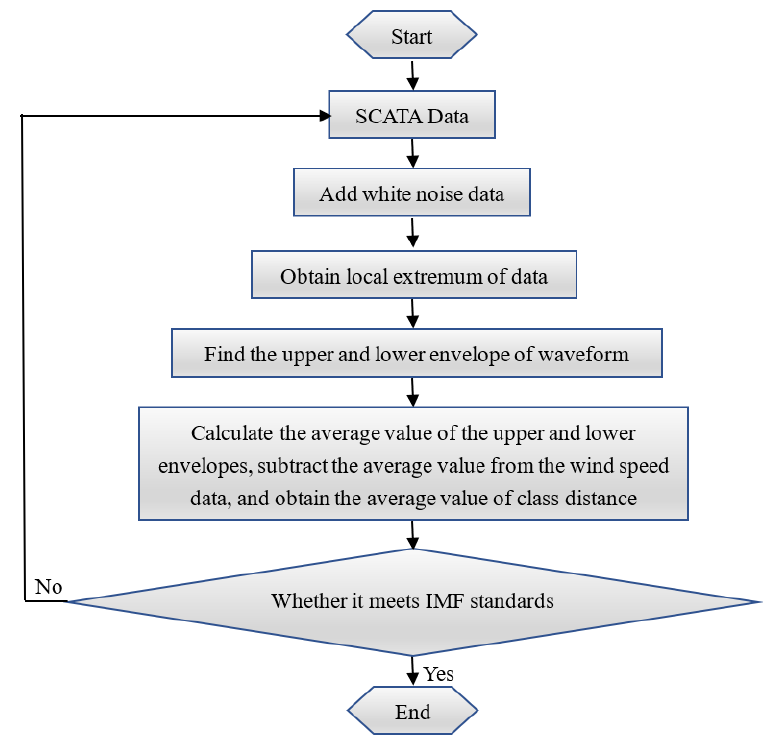
Figure 1. The decomposition steps diagram of EEMD.